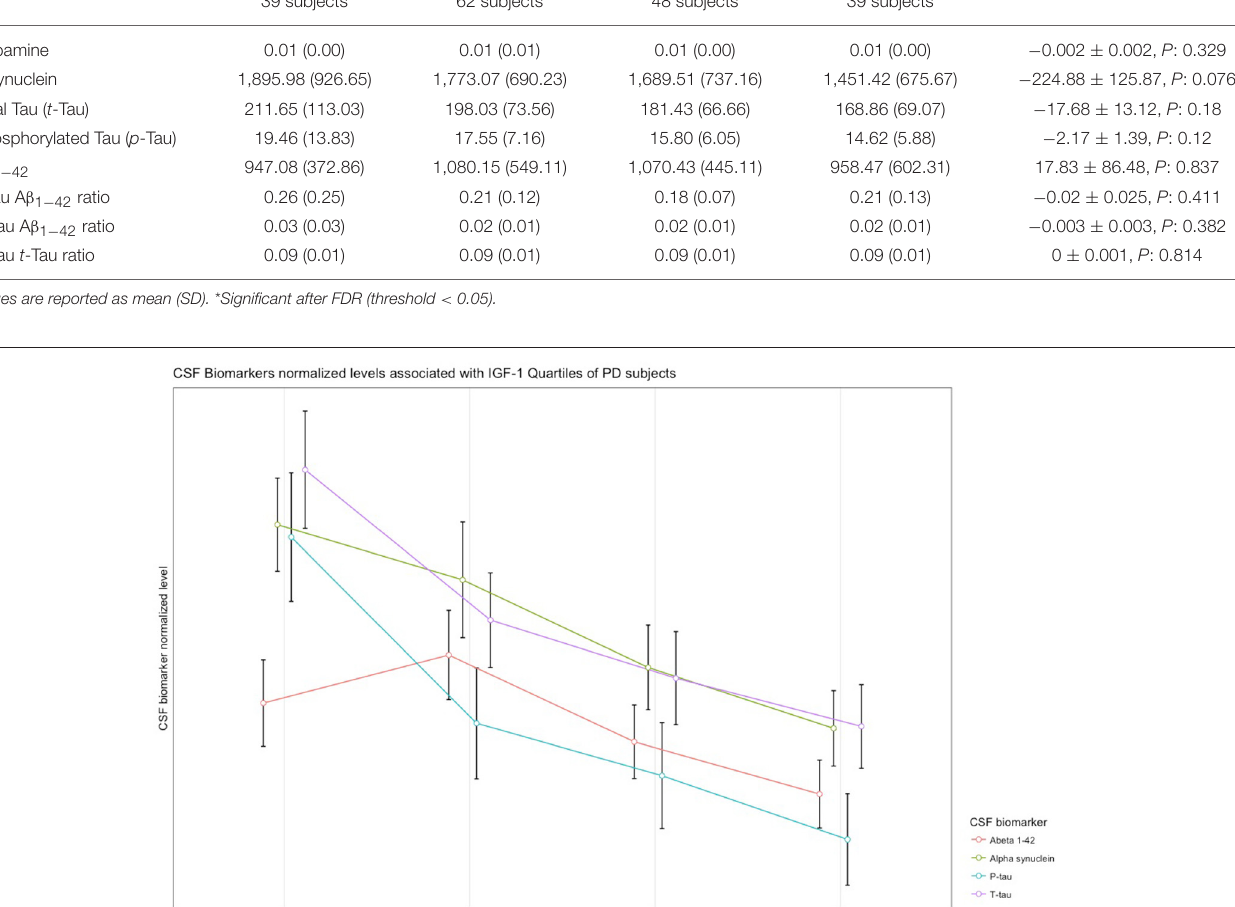
harbored temporal and parahippocampal connections ( 45–47). Remarkably, the cingulum and CC are the fibers most affected in the mild cognitive impairment, AD, and PD with dementia; The microstructural compromise in the parahippocampal and posterior cingulum, and the splenium of the CC is replicated